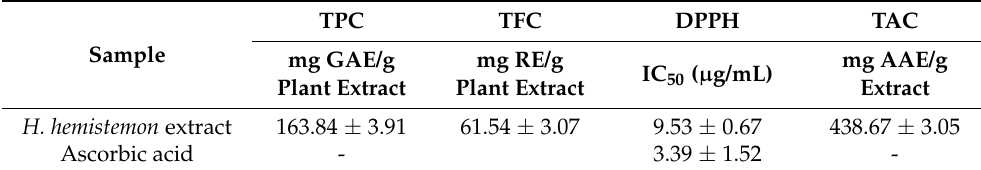
Figure 2. MS/MS spectra of esculetin glucoside (( a ), compound 7), esculetin sulfate (( b ), compound 11), and esculetin (( c ), compound 13) from Table 1. Table 2. Results of TPC, TFC, DPPH and TAC of H. hemistemon aerial-part extract. Table 1. Chemical constituents of H. hemistemon aerial ‐ part extract.